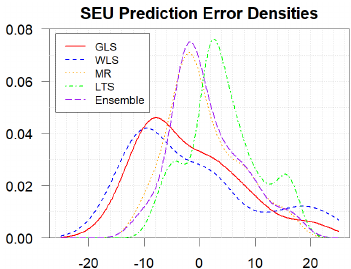
Figure 7. Density function of evaluation errors of five methods on training set.